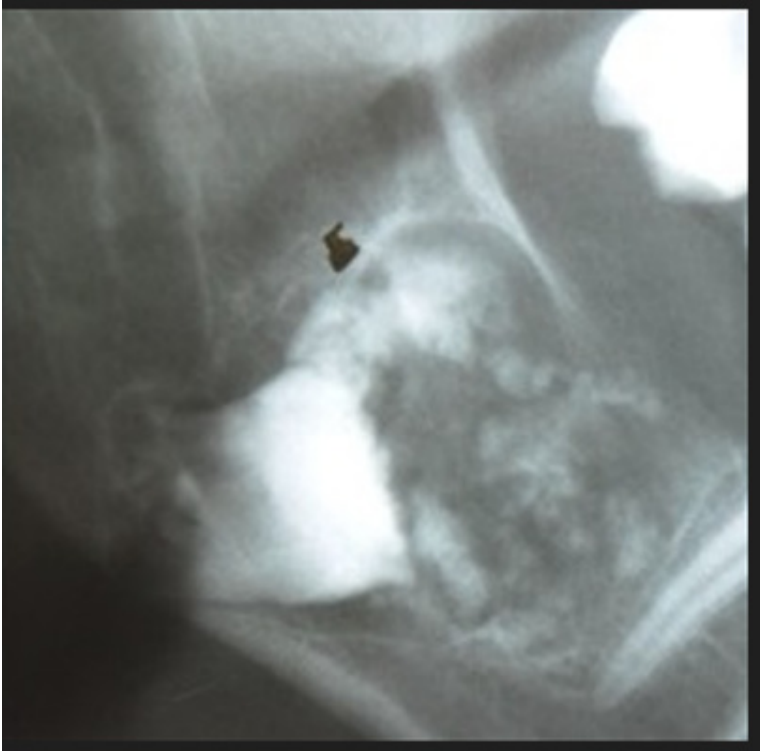
Figure 2. Enlarged visualization of the tumor mass in the right mandibular angle. Courtesy of Dr. W. Pawlak.